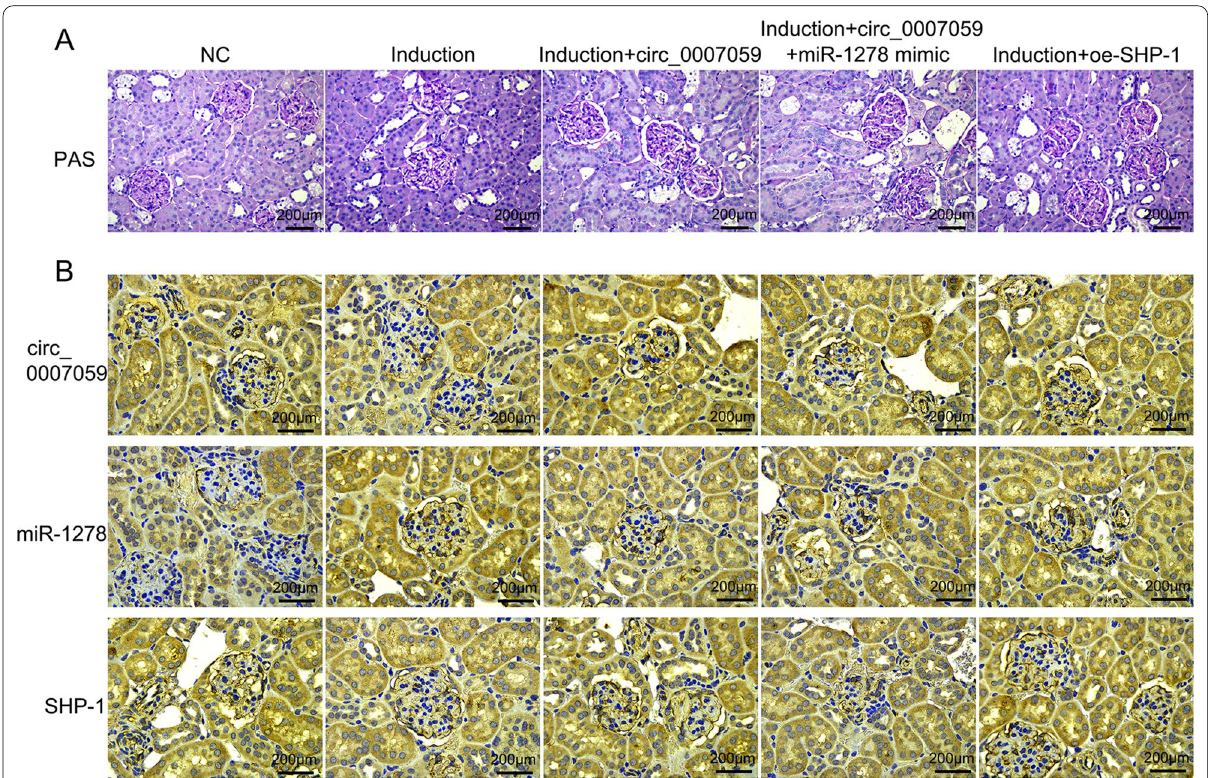
Fig. 8 Efficacy of circ_0007059 overexpression in treating IFNα‑accelerated LN. A PAS‑stained kidney sections were analyzed for renal lesion scores, which showed that circ_0007059 agomir ameliorated IFNα‑accelerated LN in mice. B Histologic analysis of circ_0007059, miR‑1278, and SHP‑1 protein expression in mice. (Biological replicates